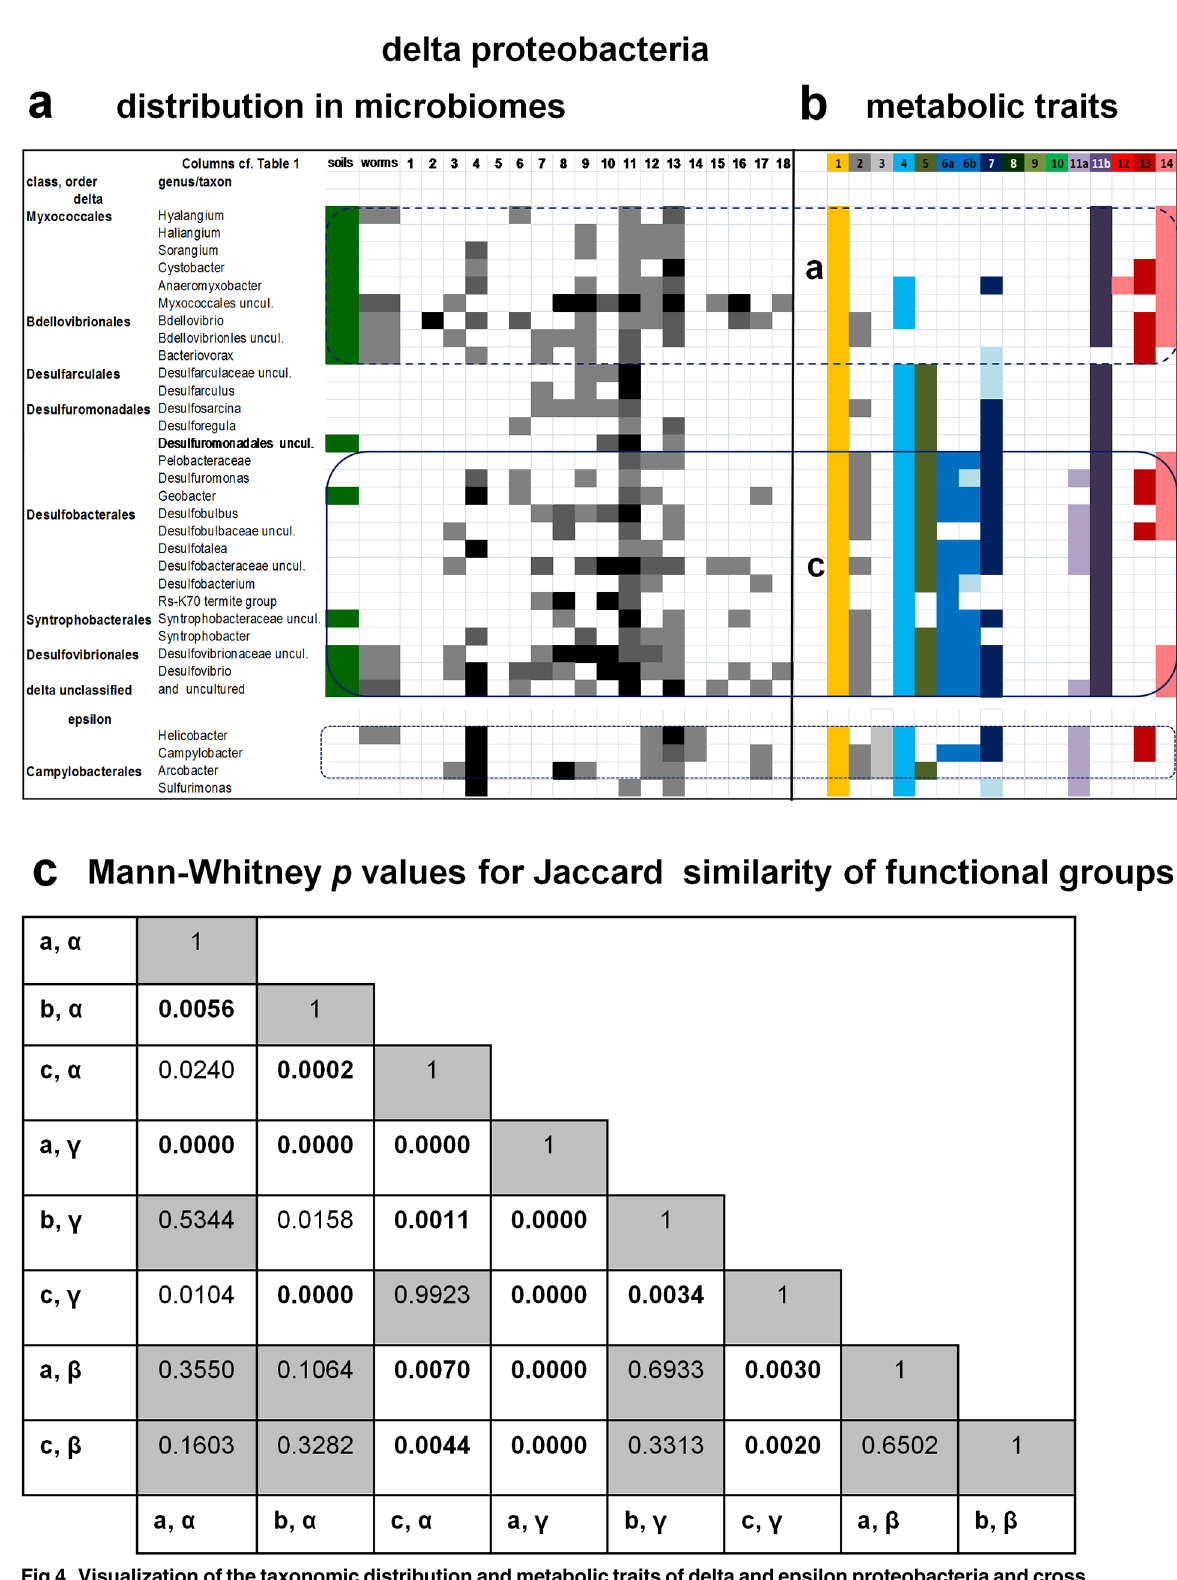
PLOS ONE | https://doi.org/10.1371/journal.pone.0176573 May 5,